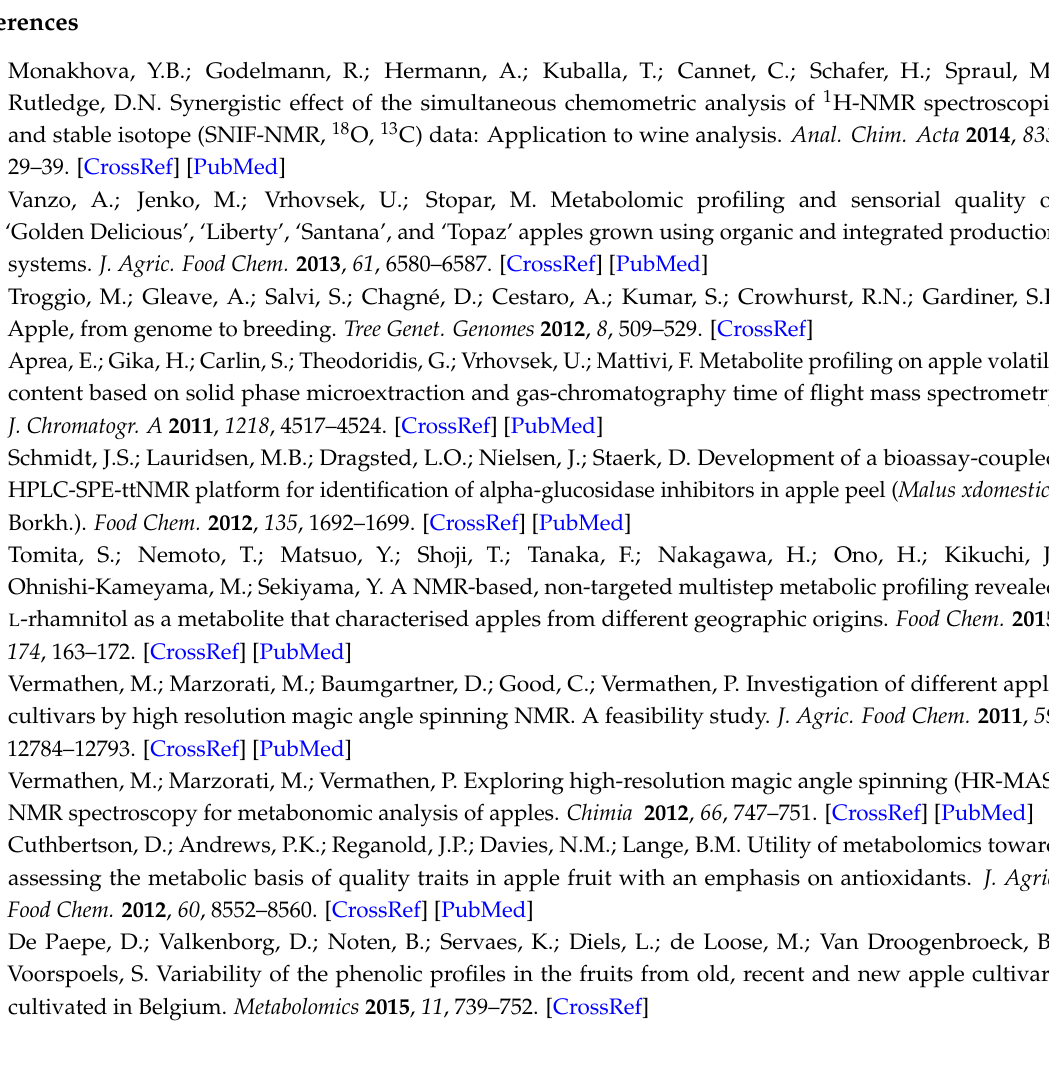
Figure S1: pH shifts observed for peel extracts exemplified for four different cultivars; Figure S2: sample variability within pulp extracts; Figure S3: Spiking with pure substances to identify polyphenolic compounds; Figure S4: Sample variability between the cultivars; Figure S5: PCA two-dimensional views; Figure S6: Reproducibility of the method; Table S1: List of identified